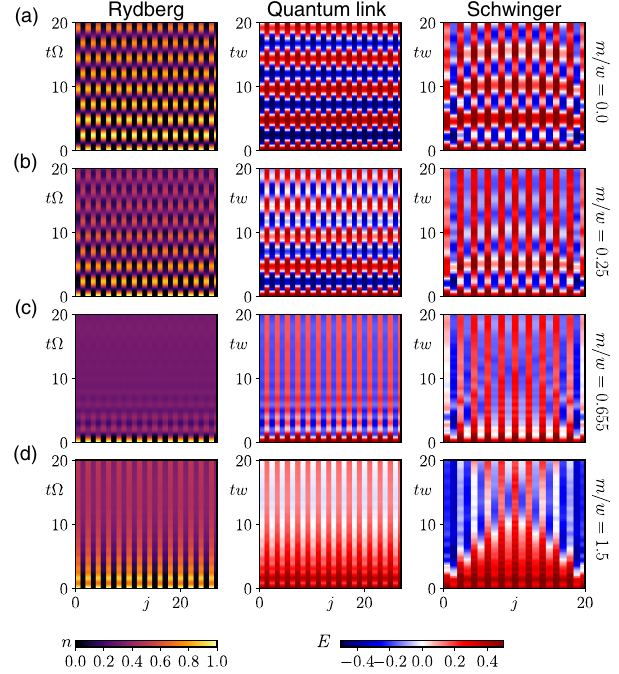
FIG. 2. Slow dynamics in Rydberg atoms, the U(1) quantum link model (QLM), and the lattice Schwinger model. Coherent quantum evolution of the local Rydberg excitation density profile (first column) n j ð t Þ ¼ h ˆ n j ð t Þi in the FSS model [see Eq. (2)], starting from a charge-density wave, of the local electric field ˆ S z t Þi in the QLM, and profile (second column) E j;j ð t Þ ¼ h j;j þ 1 ð þ 1 ˆ L t Þ − θ = ð 2 π Þi (see main text) in the lattice (third column) h j;j þ 1 ð Schwinger model [see Eq. (3)] with J=w ¼ 1 . 5 and θ ¼ π . The four rows correspond to increasing values of the detuning δ (Rydberg) or, equivalently, of the particles mass m ¼ − δ (QLM and Schwinger model). Figures 1(d) and 1(e) correspond to the first two plots in (a) here. Data in the first and second columns are connected by a unitary transformation, while a remarkable similarity is manifest between the second and third column despite the larger Hilbert space of the gauge degrees of freedom in the Schwinger model. The persistent string inversions observed within the symmetric phase with m < m c ¼ 0 . 655 j w j in rows (a) and (b) are suppressed as the quantum critical point is ap- proached. The dynamics in the third column feature edge effects due to the imposed open boundary